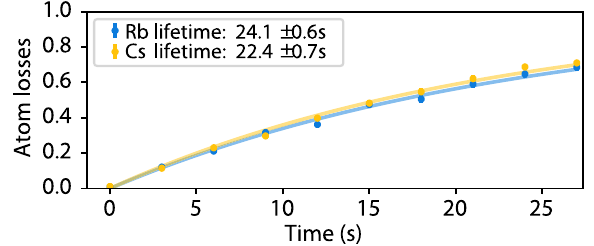
FIG. 8. Atom lifetimes in optical tweezers. Typical atom lifetimes for Rb and Cs atoms under continuous laser cooling with the PGC light while trapped in the 811 and 910 tweezers, respectively. Solid lines indicate exponential fits to the data. Error bars are smaller than the size of the